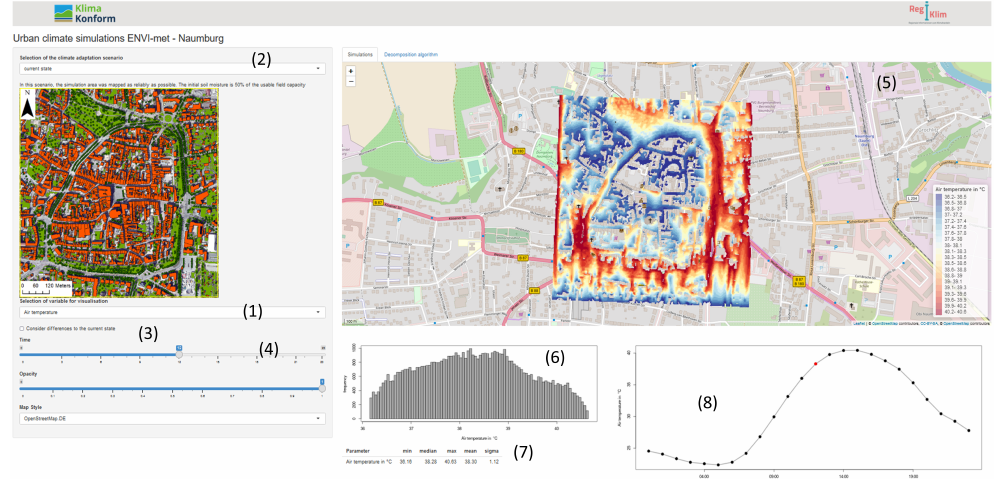
Figure 4. Screenshot of the online visualization tool: This example shows the spatial distribution of the air temperature (z = 1.4 m) for the current state at noon. The tool is accessible at https: //webapp.ufz.de//KlimaKonform//urbansimulation//Naumburg. This dashboard consists of a user interface ( left —greyish shaded part) and the corresponding output ( right ). The selection options include (1) the meteorological parameter (2) the simulation scenario, (3) the option to consider the difference compared to the current state and (4) the selection of the time. The output consists of representations for the selected input parameters which covers (5) a spatial map display, (6) a histogram of the grid values, (7) a table of some summary statistics and (8) a diurnal plot.